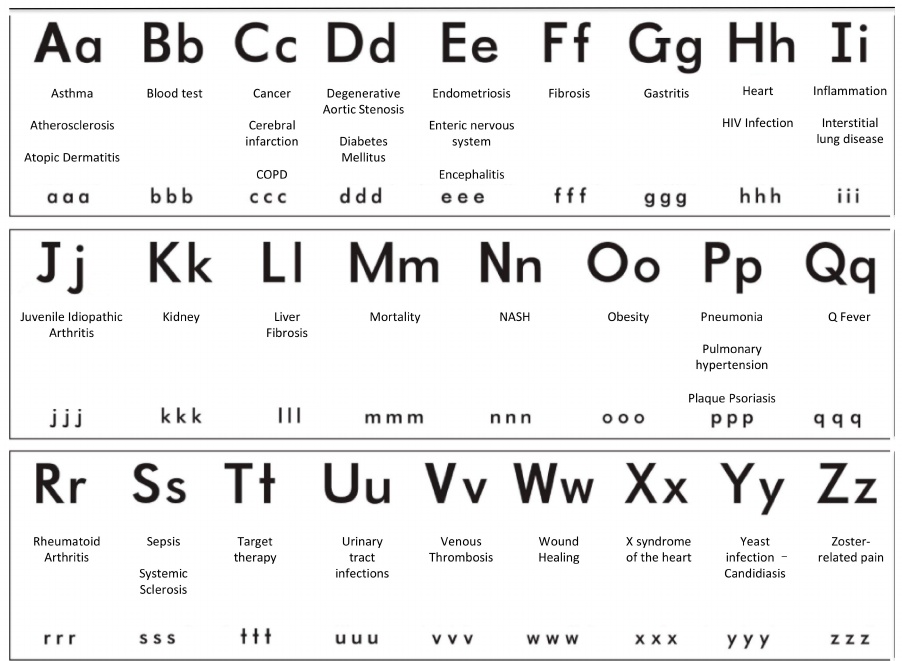
Figure 3. Conditions and diseases in which a role for Gal-3 has been postulated, listed in alphabetical